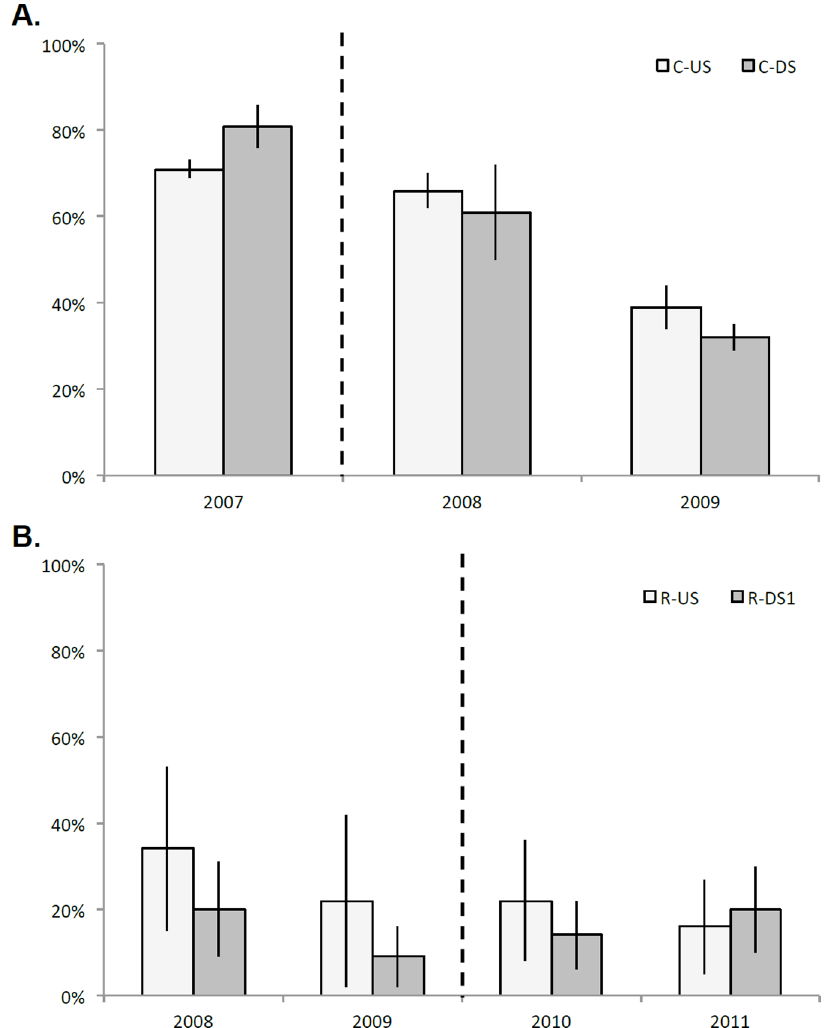
Figure 8. Mean %EPT (expressed as a proportion, + / 2 2 standard errors) per reach across A) riffle sample units on the Calapooia, and B) transects sampled on the Rogue. In both panels, year is on the x-axis, and lighter-colored bars represent the upstream reaches. Vertical dashed line shows timing of dam removal. Note that the second downstream reach is not plotted for the Rogue River due to the lack of change over